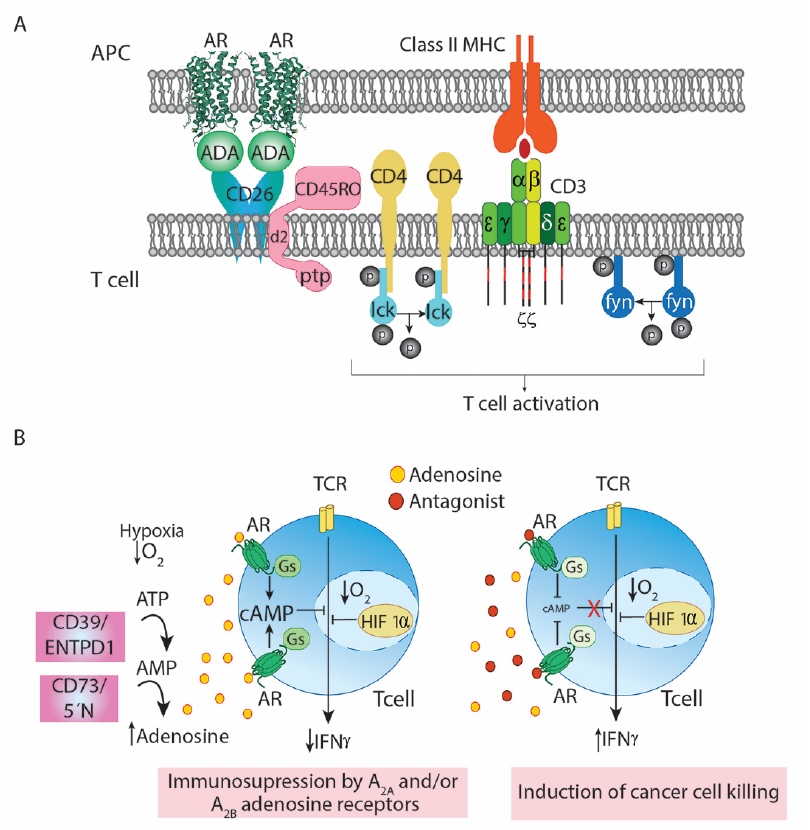
Figure 1. Immunosuppressive actions of Ado in tumor microenvironment and rescue by AR antagonists. Panel ( A ) Proposed model of the CD26/Ado deaminase/AR-mediated co-stimulation of T-cells upon antigen presentation. Protein Src kinases such as Lck (which constitutively binds to the cytosolic domain of T-cell coreceptors CD4 or CD8) and Fyn are activated following TCR/CD3/CD4 cross-linking on T-cell surface promoted by the interaction of Major Histocompatibility Complex (MHC) proteins with antigens in presenting cells. These Src kinases phosphorylate immunoreceptor tyrosine-based activation motif (ITAM) in the cytosolic region of CD3γ, CD3δ, CD3ε, and CD3ζ (red lines). Phosphorylation allows recruitment of other protein tyrosine kinases to the ITAM on CD3ζ, which is phosphorylated and activated by Lck. These other kinases will activate intracellular signaling pathways leading to T-cell activation. In parallel, ADA1 adenosine deaminase anchored to the A 2B AR on the antigen-presenting cell surface bridges the T-cell via cell surface CD26, at the same time that antigen is sensed by the T-cell receptor/CD3 complex. Subsequent to T-cell activation, CD45RO phosphatase bound to CD2, (via the d2 intracellular domain) is activated and recruited to the lipid rafts. The protein Tyr phosphatase (ptp) domain of CD45RO catalyzes the dephosphorylation of the regulatory domain of Src kinases including Lck and Fyn, thus inducing Src kinase activation. The model shown is similar for CD4 + T cells and CD8 + T cells. Abbreviations: d2, intracellular domain d2 of CD45RO; ptp, tyrosine-phosphatase domain of CD45RO. Adapted with permission from ref. [48]. Panel ( B ) Mechanism by which antagonists of G s -coupled ARs rescue the anti-tumor activity of effector T cells. Elevated extracellular (Ado) in the tumor environment leads to immunosuppression. The hypoxia-induced increase in the expression of two ecto-nucleotidases, CD39 (ecto-nucleotide tri(di)phosphohydrolase-1 -ENTPD1-) and CD73 (5′-nucleotidase -5′N-)) in the tumor microenvironment results in enhanced conversion of extracellular adenine nucleotides into extracellular Ado. Activation of ARs leads to increases in cAMP, thus leading to impaired function of the effector cells of the immune system. Hypoxia also stabilizes the transcription factor HIF-1a, which cooperates with the ARs to suppress T-cell effector functions (left). Blockade of G s -coupled ARs (A 2A R and A 2B R) restores the levels of intracellular cAMP, rescues the immunosuppression and enhances cancer cell killing by effector cells (right). Adapted with permission from ref. [63].